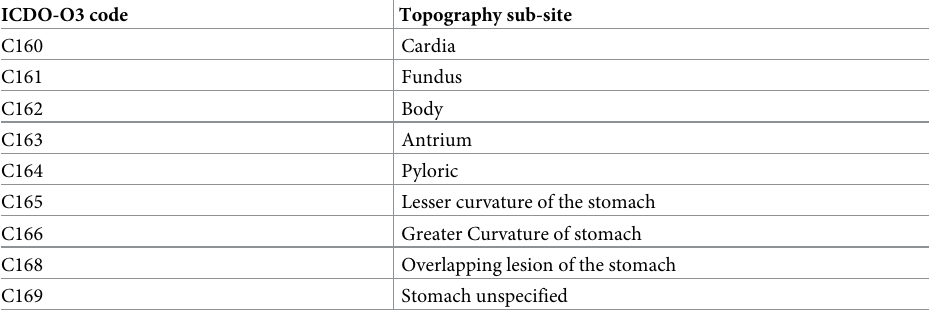
Table 1. Description of all GC topographies using